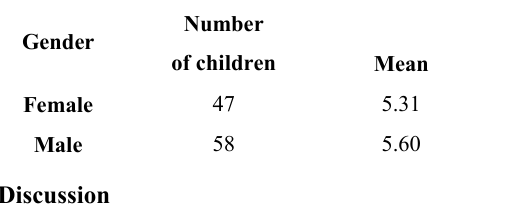
Table 2. Serum neopterin level according to children's